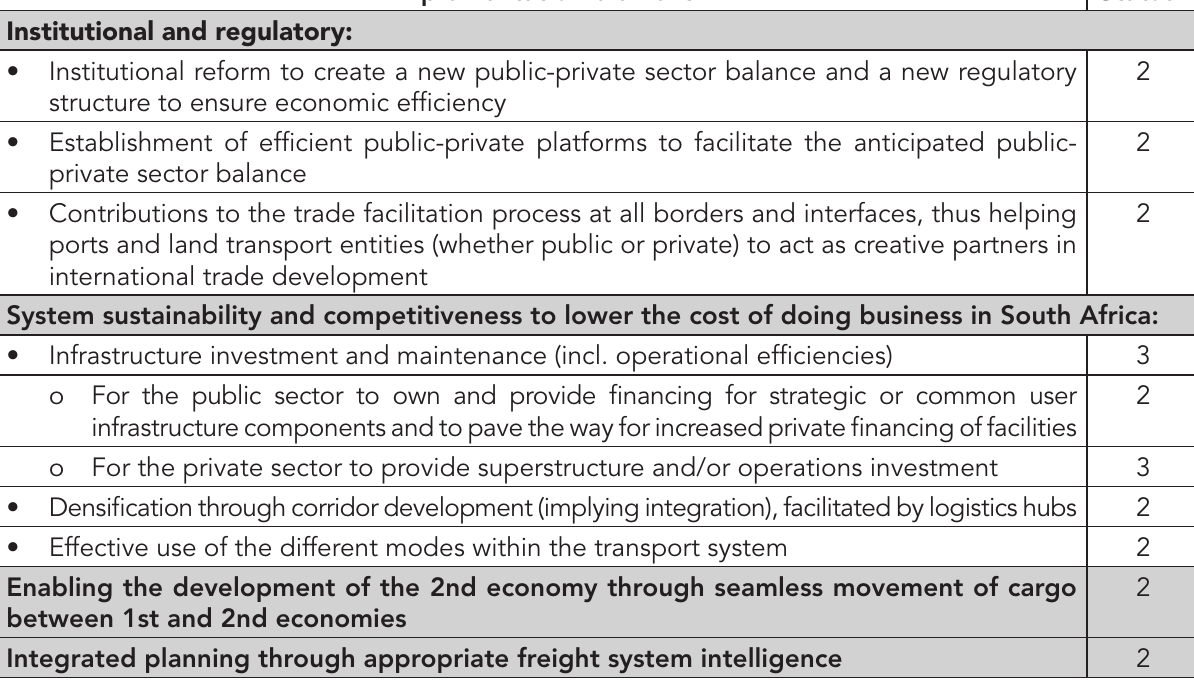
Table 3: Key implementation elements identified by the MSA and the NFLS (based on DoT, 1998 and 2005); and a view on the implementation status (author’s own analysis based on research conducted) Implementation element